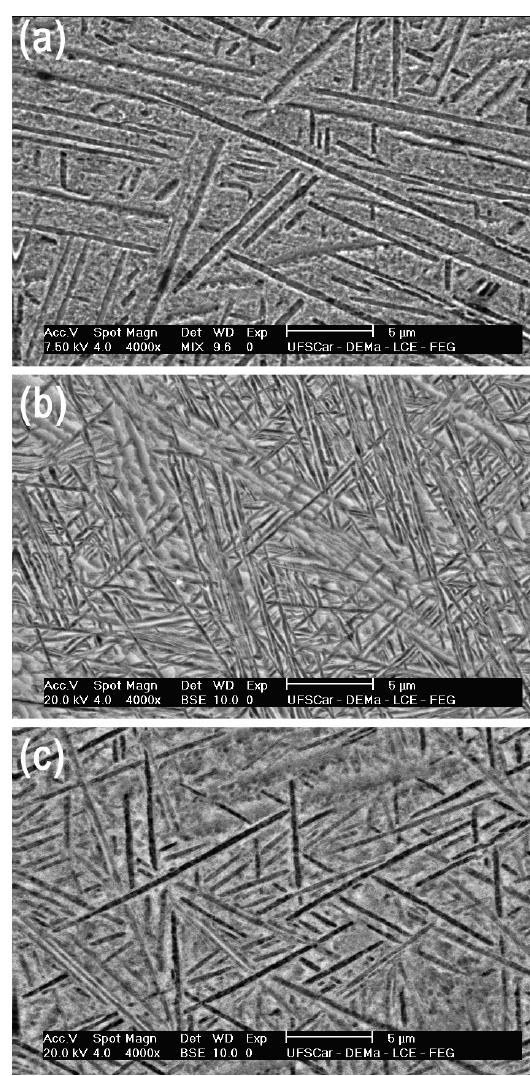
Figure 2. SEM micrographs of Ti-9Mo alloys, (a) as received, (b) after annealing, and (c) after doping with oxygen.